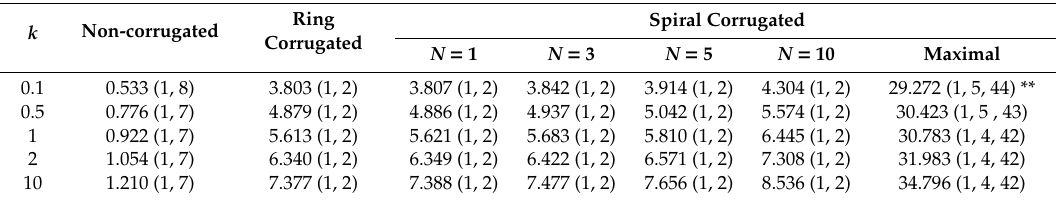
Table 3. The critical buckling pressures of non-corrugated and round corrugated sandwich FGM